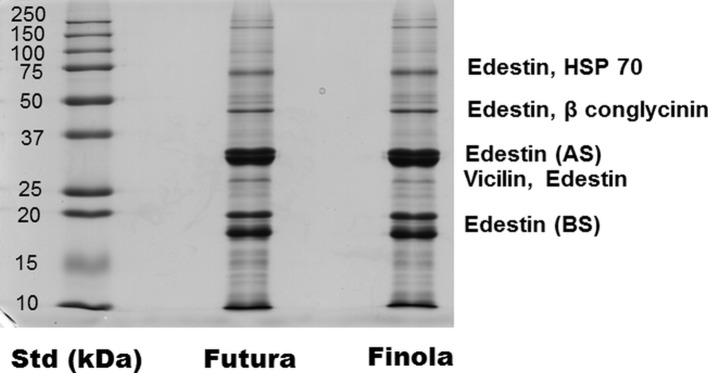
SDS-PAGE profile of hemp seed proteins. Resolved proteins were detected by Colloidal Coomassie staining and identified by MS/MS analysis.